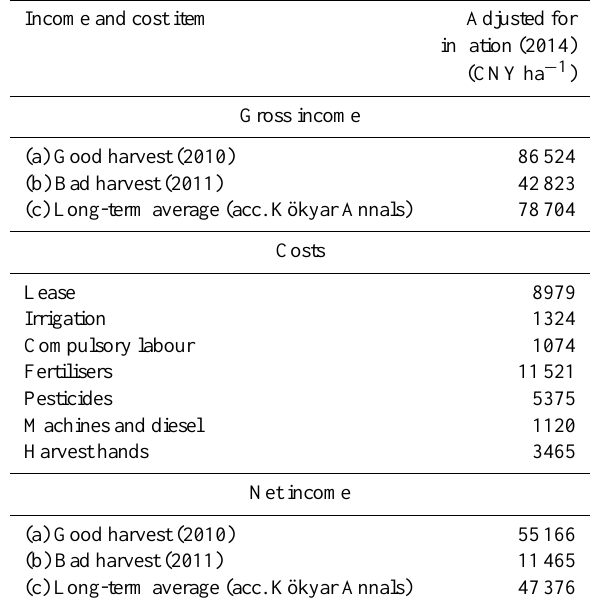
Table 6. Averaged net incomes per working day of Kökyar I farm-